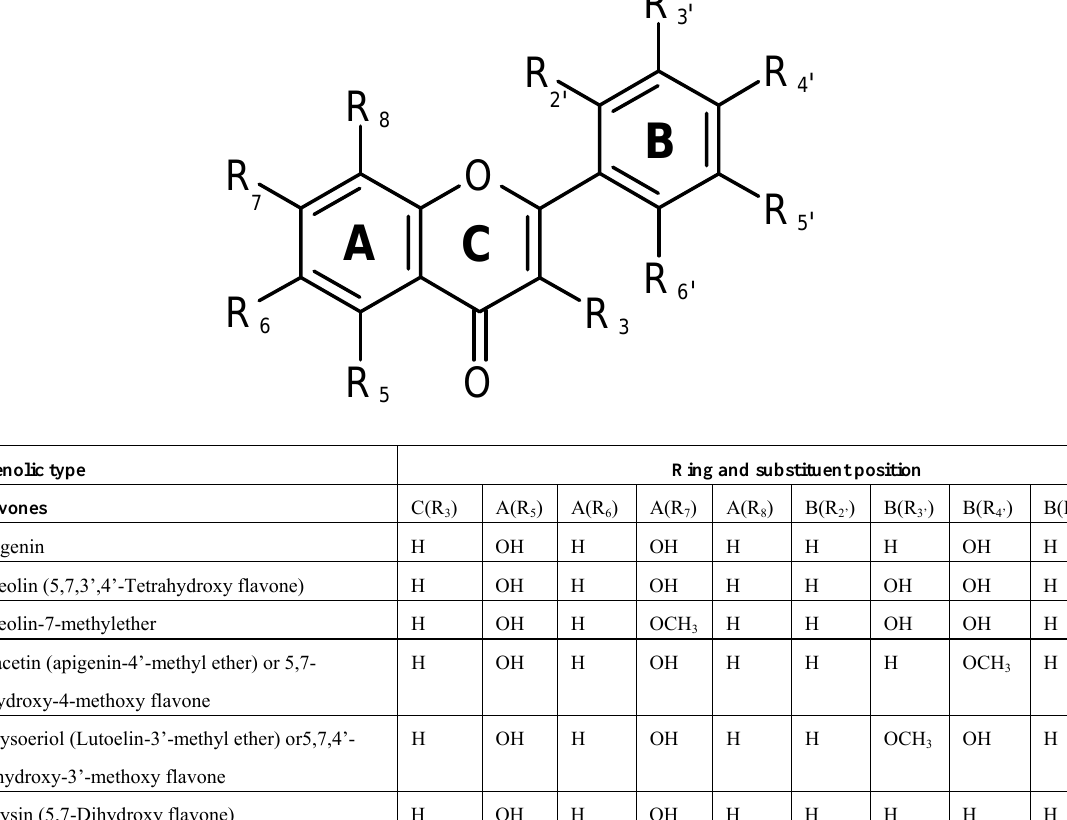
Table 1. Major phenolics reported from Artemisia annua and the general structure of flavonoids. The number refers to the number given to each compound in Figure 2. Compounds with a 3-OH group attached to the 2,3-double bond, and adjacent to the 4-carbonyl group in the C ring are predicted to have major antioxidant activity [29]. Substituents (R) are numbered according to the ring position (A, C, and